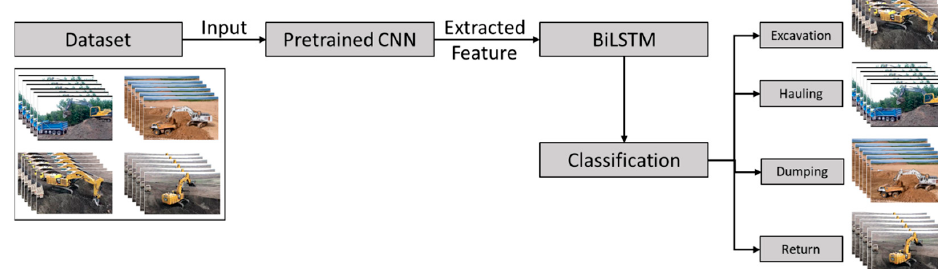
Figure 2. Overview of the research framework.